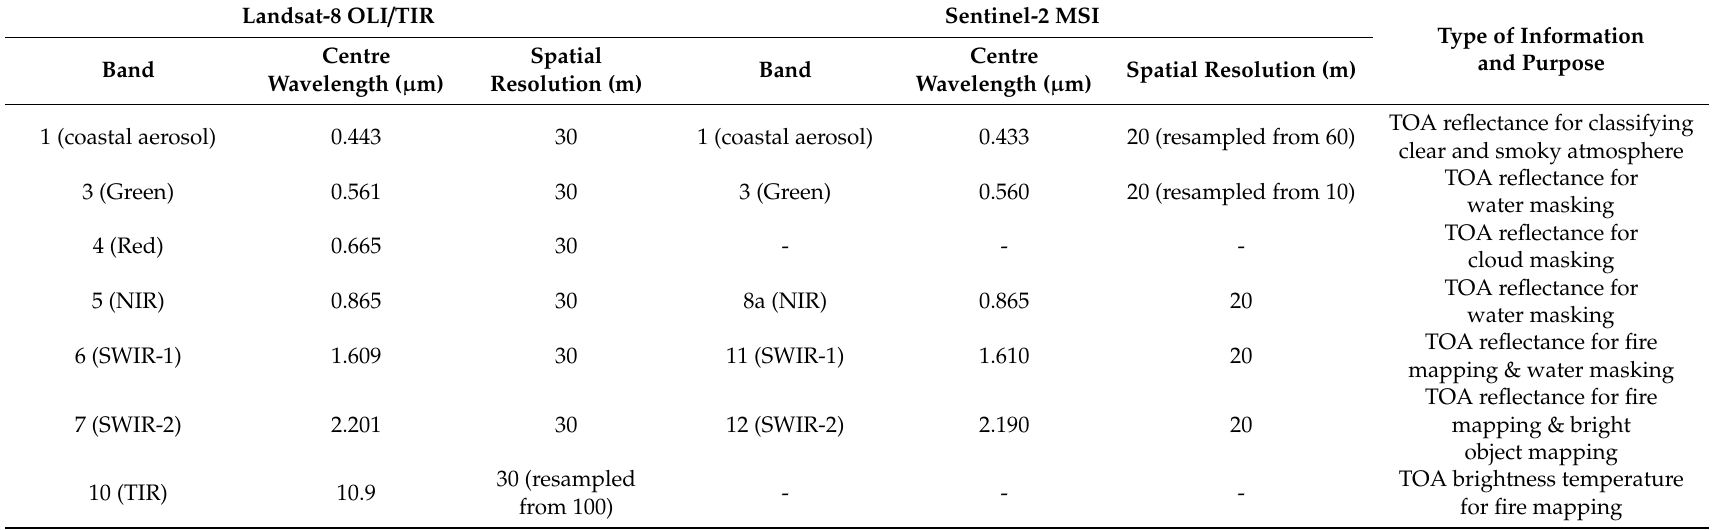
Table 2. Landsat-8 OLI and Sentinel-2 Multi Spectral Instrument (MSI) spectral band information used in Tropical Peatland Combustion Algorithm (ToPeCAl) and background mapping